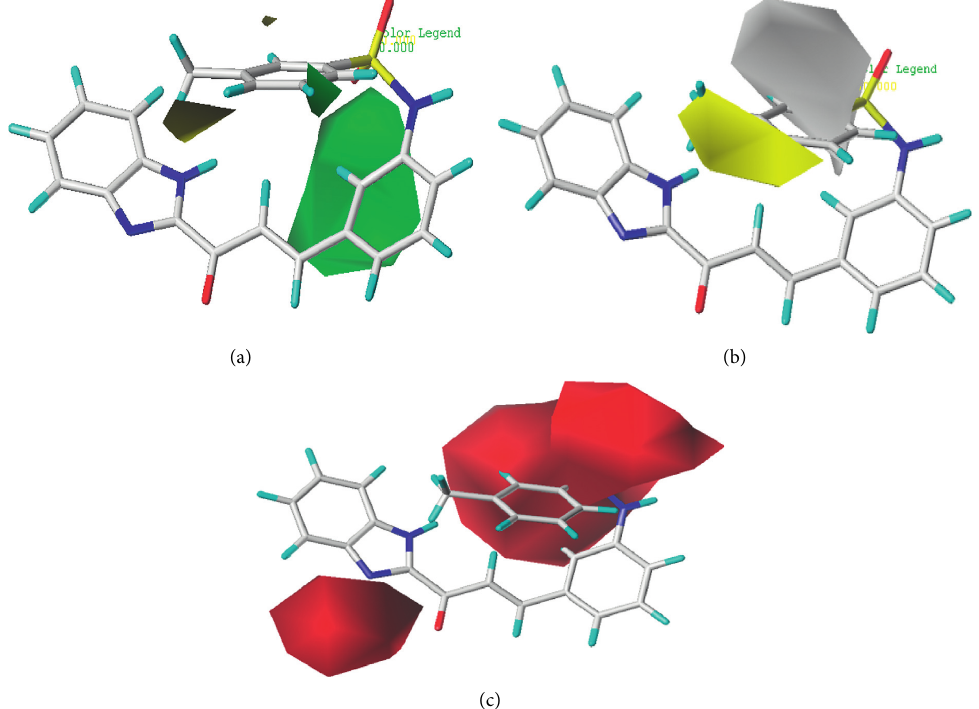
Figure 8: Steric (a), hydrophobic (b), and hydrogen-bond acceptor (c) contour maps of the CoMSIA